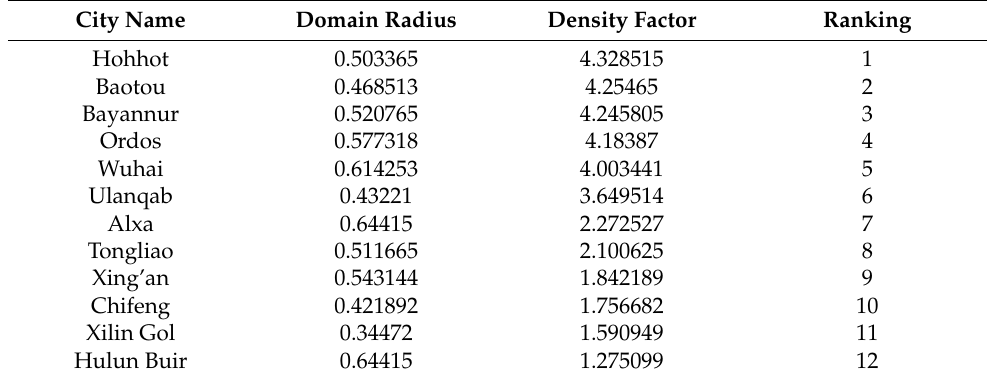
Table 3. Domain radius r a and density factor D i for each